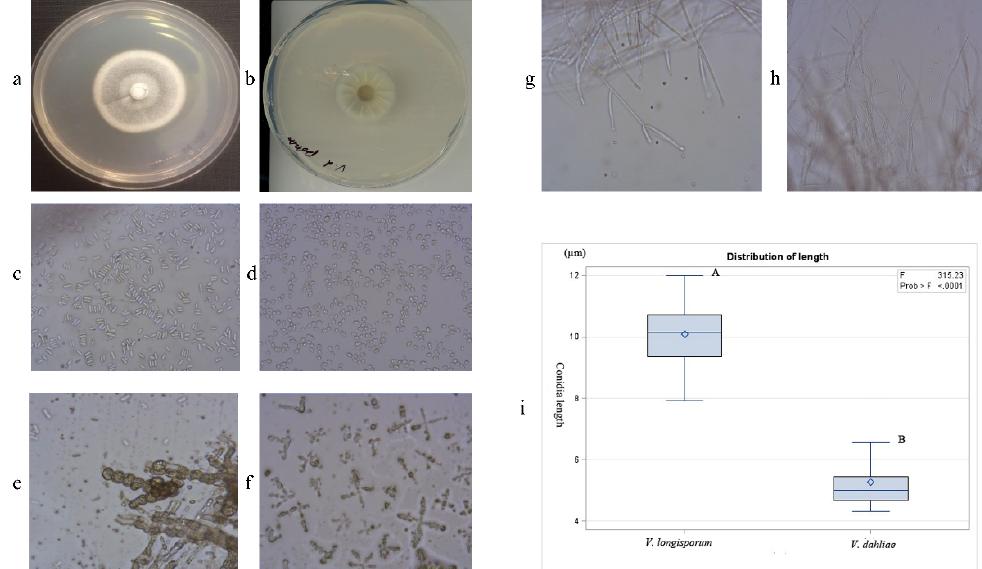
Figure 1. Morphological comparison of isolate VL-H1 of Verticillium longisporum ( a , c , e , g ) with Vd1396-9 of Verticillium dahliae ( b , d , f,h ). ( a,b ) Culture characteristics of Verticillium isolates; ( c , d ) Conidia observation ( × 40); ( e , f ) Microsclerotia ( × 40); and ( g , h ) Hyphae ( × 40). ( i ) Statistical analysis of V. longisporum and V. dahliae conidia length.